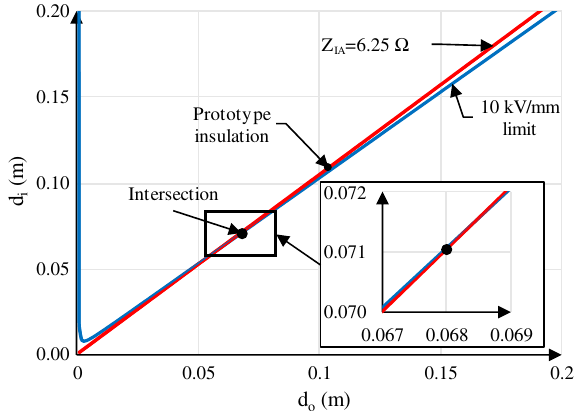
FIG. 3. Dimensions for oil as an insulation material, for an output voltage of 15 kV, for an electric field of 10 kV = mm and a characteristic impedance of 6 . 25 Ω .